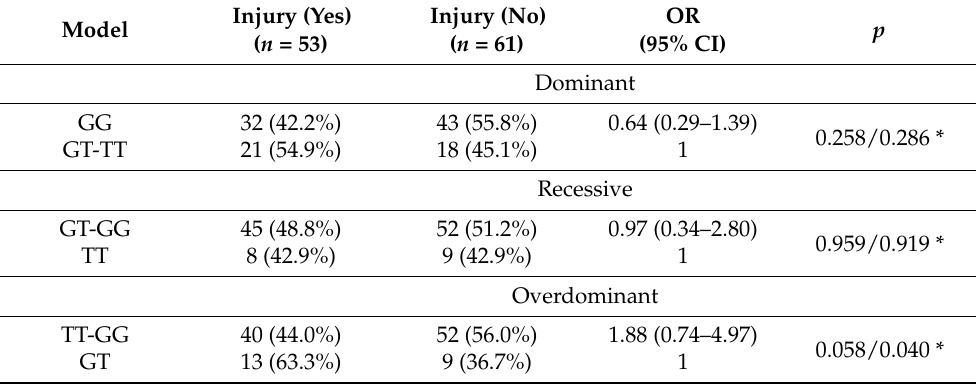
Table 2. Association of the rs1800012 COL1A1 polymorphism with injury